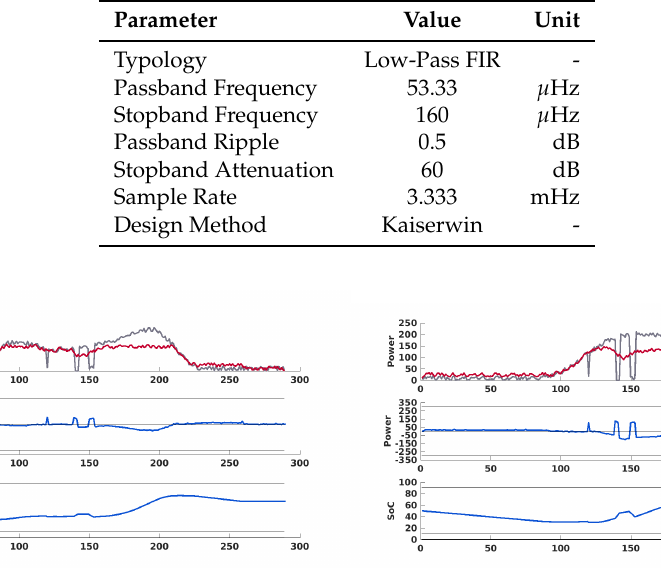
Table 4. Low-pass FIR filter characteristics.